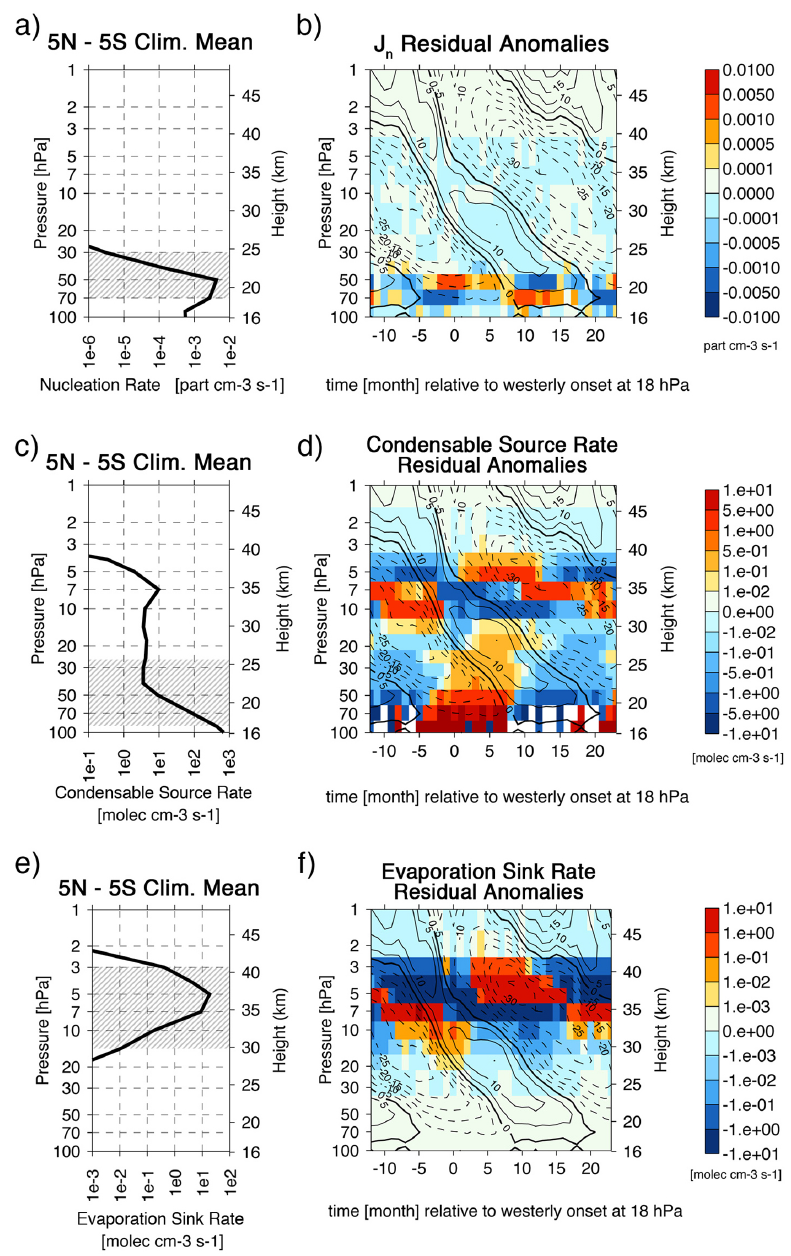
Figure 11. As in Fig. 6, except for modelled microphysical processes. The upper panel shows the binary homogeneous nucleation rate (cm − 3 s − 1 ) as parameterised by Vehkamäki et al. (2002). The middle panel shows the time-averaged condensable source rate of H 2 SO 4 vapour (cm − 3 s − 1 ) and the bottom panel the respective counterpart, the time-averaged evaporation sink rate of H 2 SO 4 molecules (cm − 3 s − 1